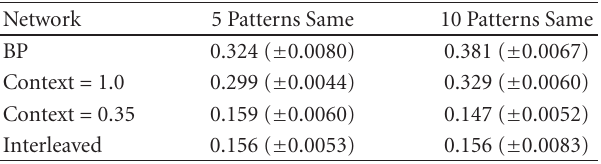
Table 4: Mean and standard error of RMS di ff erence in the hidden layer activation for the common subtask between Base Task and the interfering task. The first row gives the RMS value for a BP network, the second row for a Leabra network with contextual cues of strength 1.0, the third row for a Leabra network with contextual cues of strength 0.35, and the fourth row for a Leabra network trained in an interleaved manner for the two